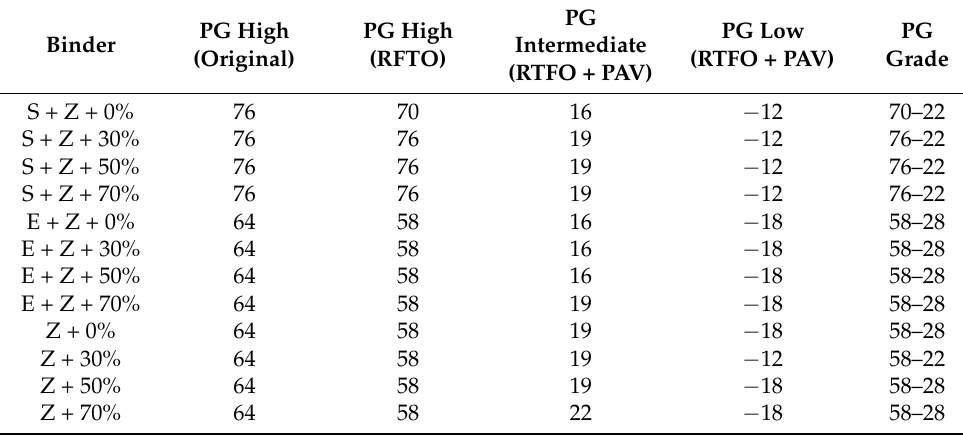
Table 13. Performance grading (PG) grades of the warm-mix recycled binders.